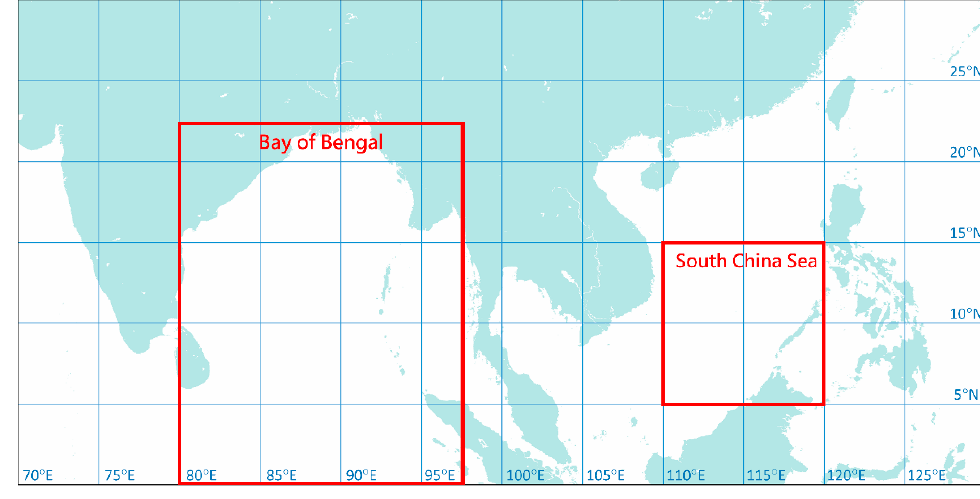
Figure 3. Two monsoon moisture surveillance domains in the South China Sea (110–120°E, 5–15°N) and the Bay of Bengal (80–97.5°E, 0–22.5°N). and the Bay of Bengal (80–97.5 ◦ E, 0–22.5 ◦